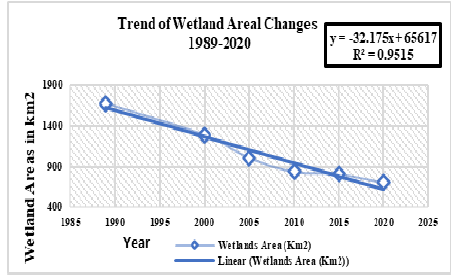
Figure 2 . Wetland change trends in NW